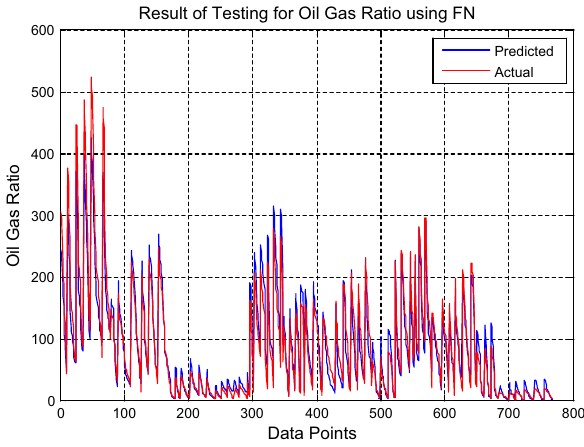
Fig. 7 Predicted and actual R for training